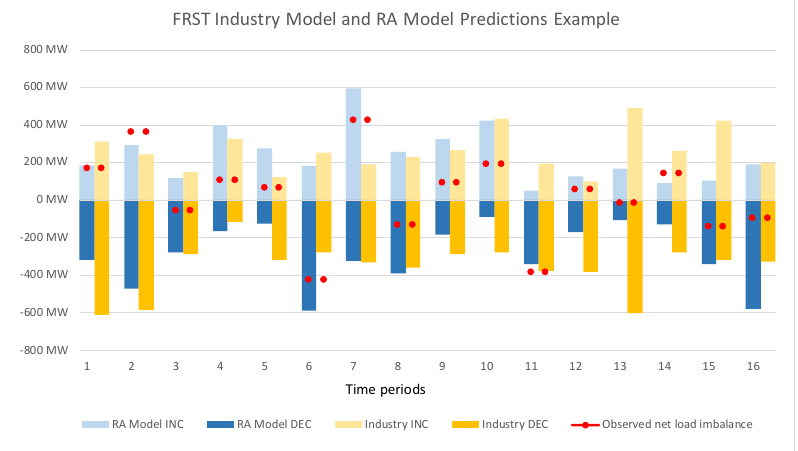
Figure 6. FRST Industry Model and RA Model Predictions Example.